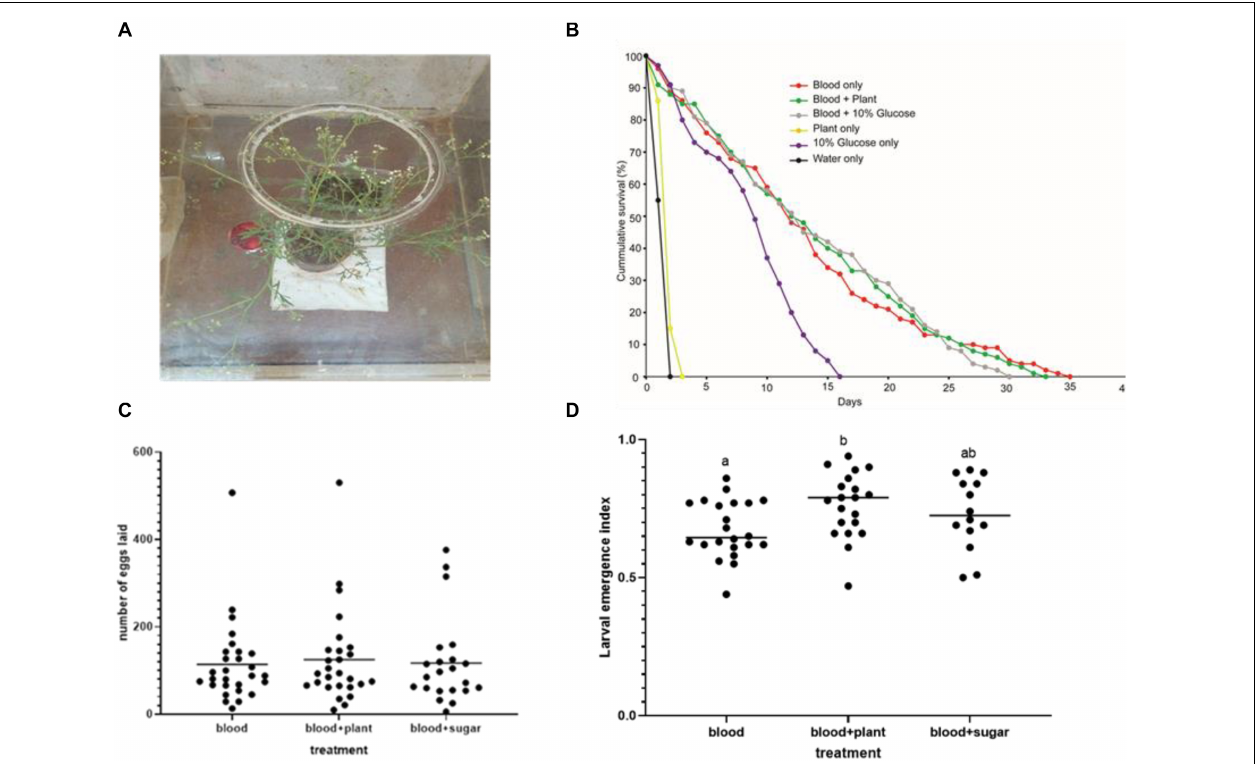
FIGURE 2 | Fitness benefits of sugar feeding in adult stable flies. (A) Feeding bioassay, intact flowering Parthenium hysterophorus used as plant nectar source and blood meal in the Petri dish. (B) Kaplan–Meier curve showing the survival of adult stable flies when fed under five different feeding regimes including negative (water) and positive control (blood) (log-rank χ 2 test, n = 5), p < 0 . 05. (C) Number of eggs laid per female stable fly according to the three tested treatments (blood, blood + plant, and blood + sugar). (D) Egg hatchability percentage across the three treatments; different letters show significant difference in larval